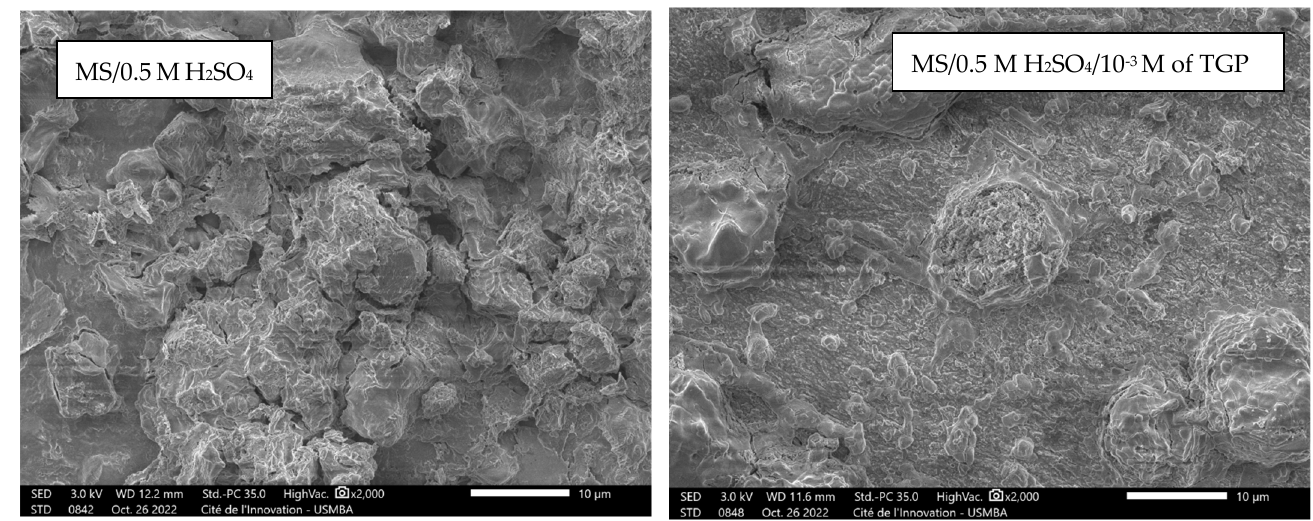
Figure 3. SEM images for uninhibited and inhibited MS substrates immersed in 0.5 M H 2 SO 4 with 10 − 3 M of inhibitory resin.